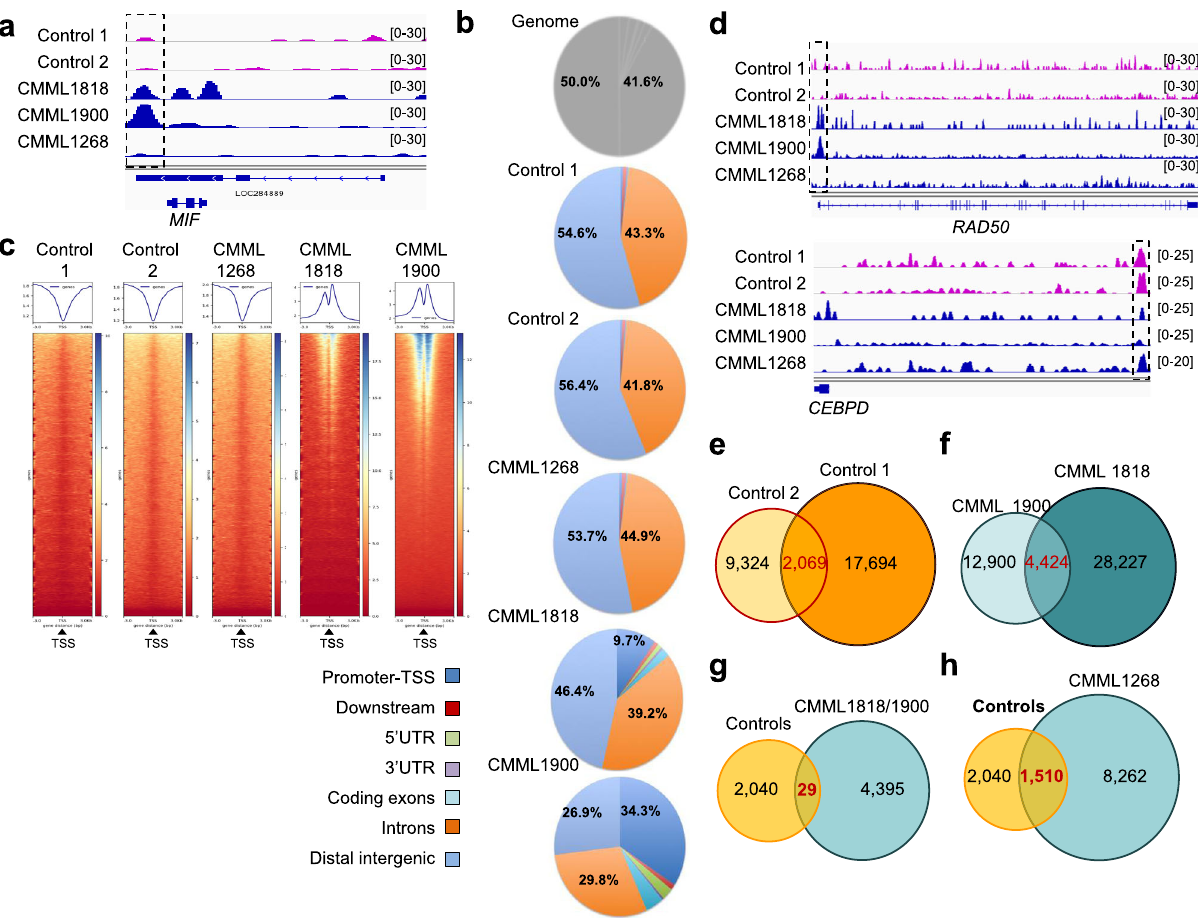
Fig. 6 EGR1 recruitment to DNA is modi fi ed by TET2 mutation in monocytes. ChIP-seq experiments were performed using an anti-EGR1 antibody in sorted peripheral blood monocytes from 2 healthy donors (control 1 and 2) and three CMML patients (CMML1268: TET2 H800fs, VAF = 16%; CMML1818: TET2 A1241fsX1, VAF = 40% and TET2 E1513GfsX9, VAF = 49%; CMML1900: TET2 W564X, VAF = 100%). a Peak calling for EGR1 on MIF gene in controls (pink) and CMML (dark blue). b Repartition of EGR1 peaks on the genome compared to hg19 reference annotation (genome). c Ranking heatmaps of EGR1 peaks centered on gene transcription starting sites (TSS). d Peak calling for EGR1 in control (pink) and CMML (dark blue) monocytes on RAD50 and CEBPD genes. e Venn diagram of peak calling in two healthy donors and f two CMML samples with high VAF trTET2 MUT . g Venn diagram of peak calling comparing two controls and two CMML samples with high VAF trTET2 MUT or h with the CMML sample with low VAF trTET2 MUT